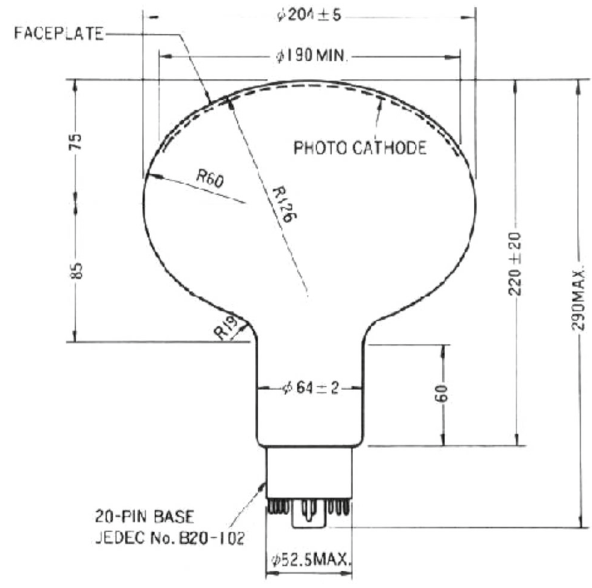
Fig. 16 Dimensions and geometry of the Hamamatsu R1408 photo- multiplier